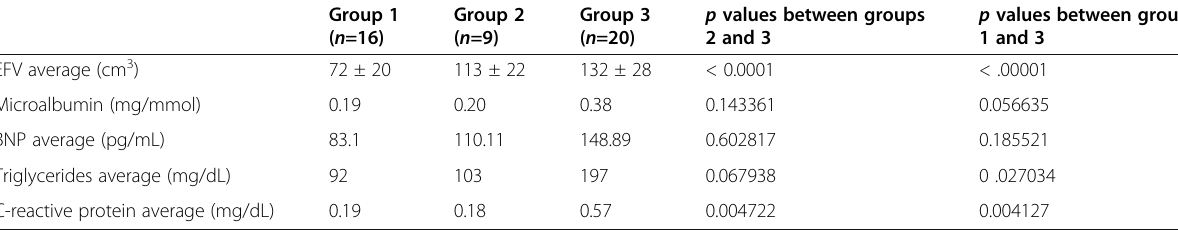
Table 3 Cardiovascular disease biomarkers in the study groups